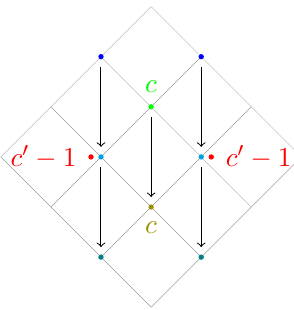
Figure 16 . The Hodge-Deligne diamond of type III c with its decomposition into primitive parts (4.49). The action of N (cid:0) are labelled by arrows, and we use colours to highlight the primitive 1 subspaces P 3 ( N (cid:0) ), P 4 ( N (cid:0) ), P 5 ( N (cid:0) ) and their images under the action of N (cid:0) 1 1 1 sl (2)-triples are commuting, the primitive subspaces P 3 ( N (cid:0) under N (cid:0) are preserved by N (cid:0) . 1 2